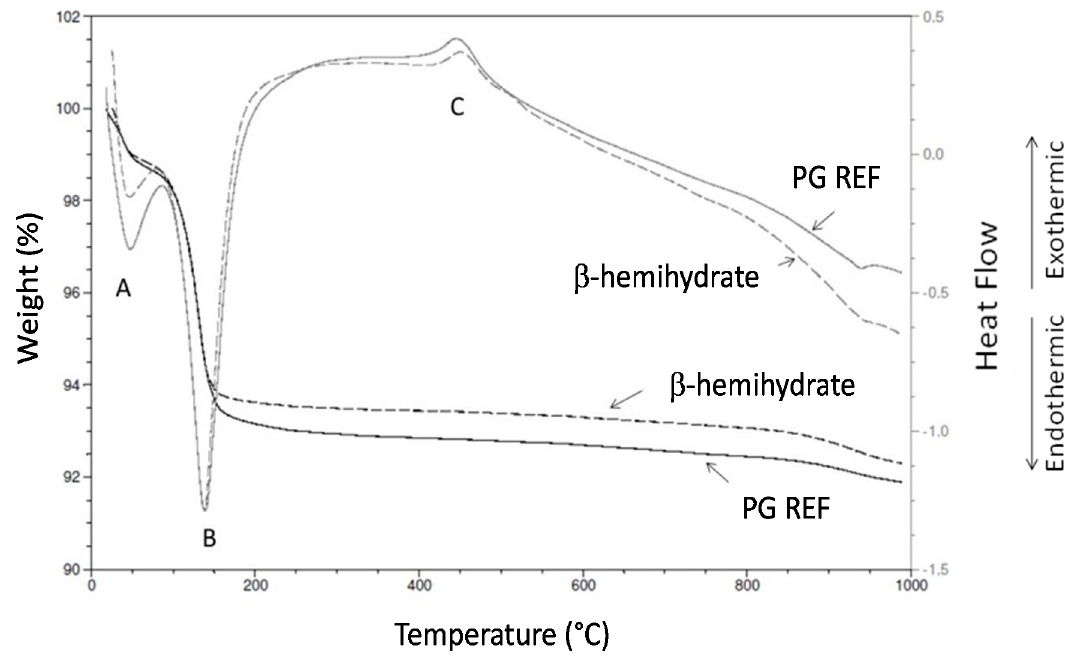
Figure 2. Thermal analysis of phosphogypsum (PG REF) and β -hemihydrate.